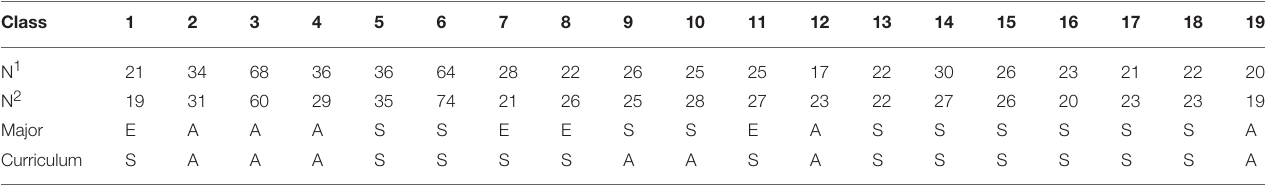
TABLE 2 | Student numbers, major type, and curriculum type for each